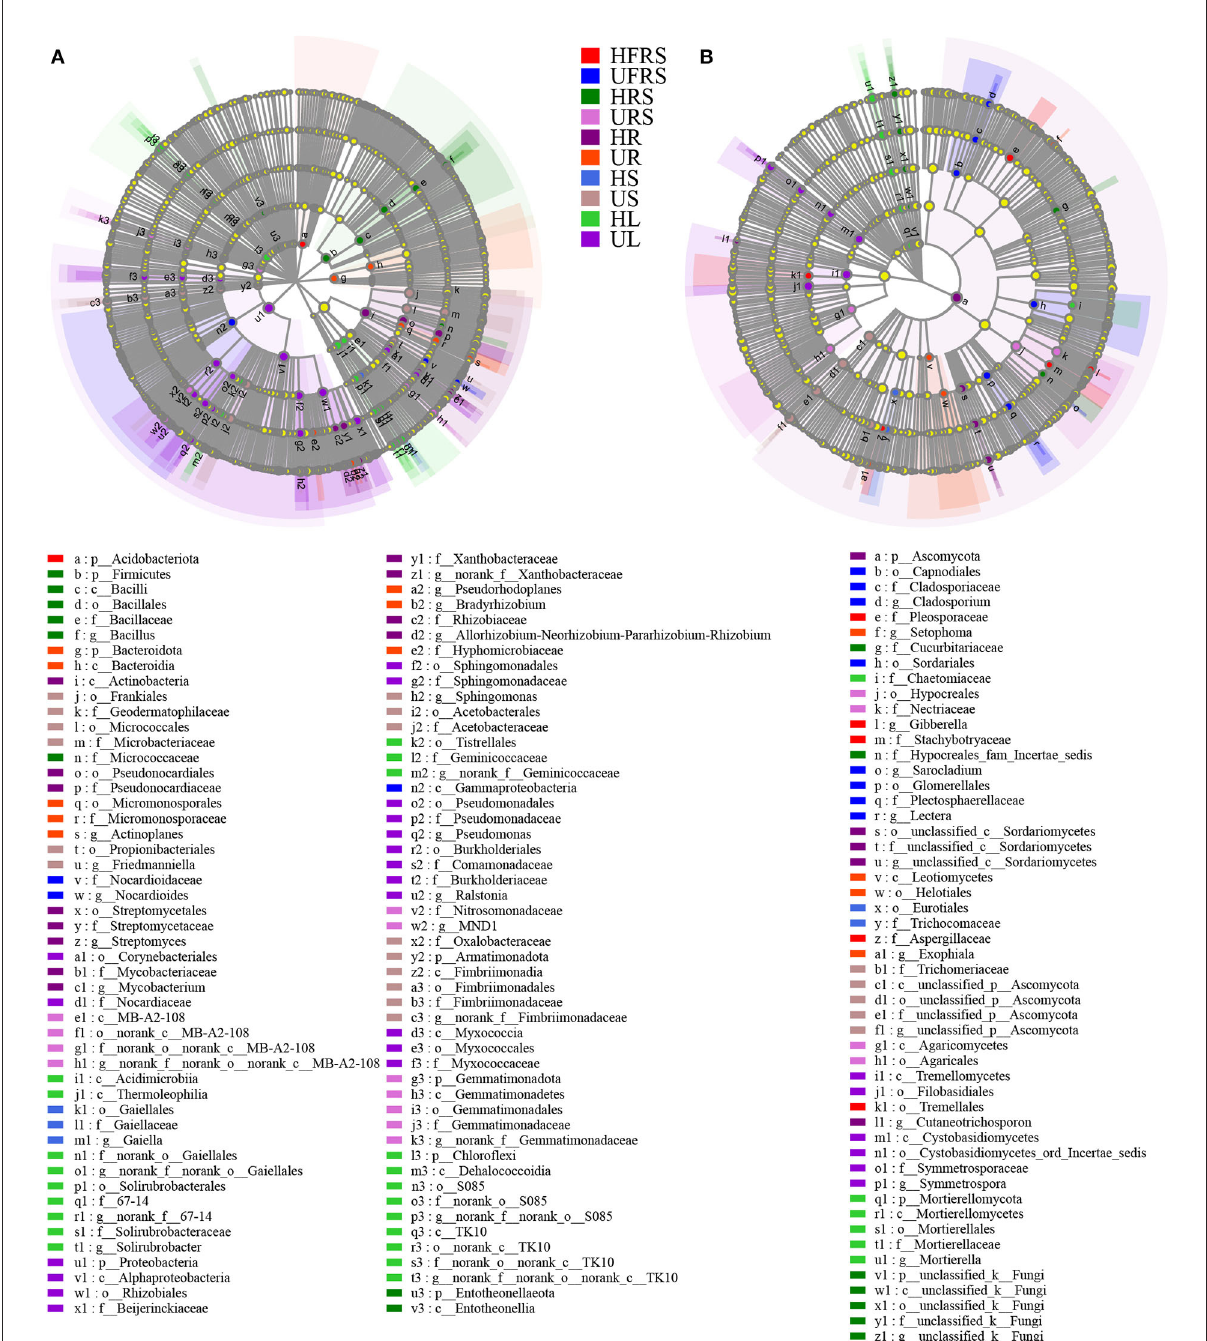
FIGURE6 LEfSe (LDA > 4) showing the phylogenetic distribution of (A) bacterial and (B) fungal microbial taxa (from phylum to genus) in rhizospheric and bulk soils, and different compartments (roots, stems, and leaves) of healthy and unhealthy P. bungeana plants. LEfSe analysis was used to search for microbial taxa that were statistically different between groups. The identified microbial taxa are represented as nodes marked with letters in the LEfSe diagram. The circles radiating from the inside to the outside represent the classification levels from phylum to genus. The differently colored regions represent different samples (red, HFRS; dark blue, UFRS; dark green, HRS; pink, URS; dark purple, HR; orange, UR; light blue, HS; brown, US; light green, HL; and light purple, UL). The species with no significant differences ( P > 0.05) are uniformly colored in yellow, and the different species are colored according to the group. The colors of the nodes correspond to microbial groups that play an important role in the correspondingly colored groups. Abbreviations of variables are given in Figure